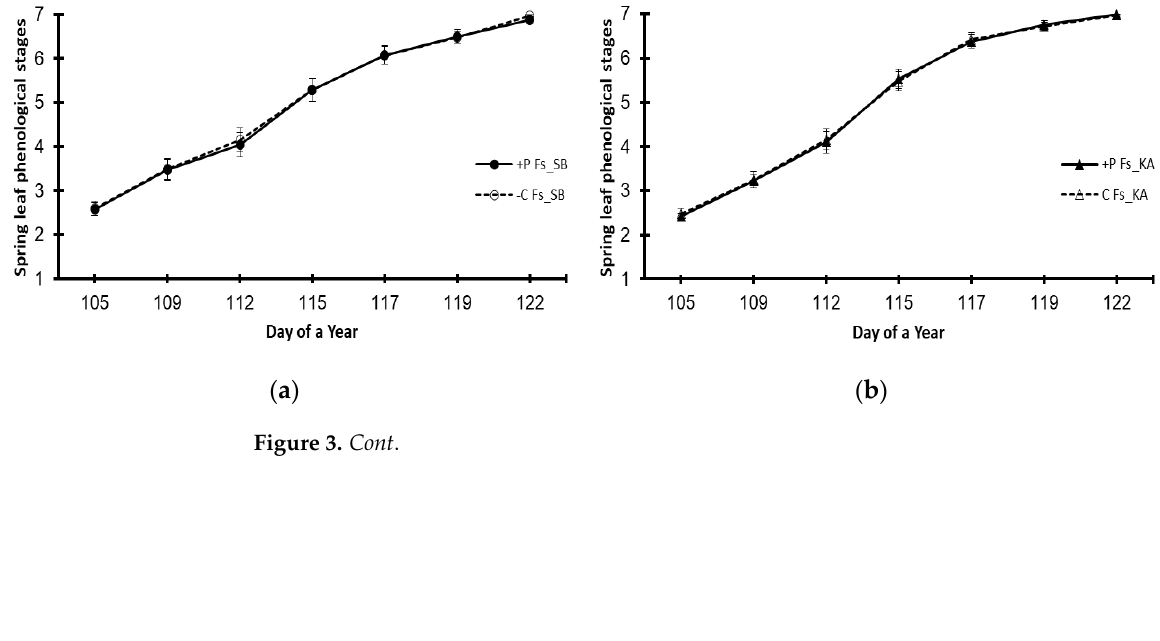
Figure 2. Autumn leaf phenologies of beech (Fs) and oak (Qp) saplings in 2021, by provenance and treatment: ( a ) beech provenance SB; ( b ) beech provenance KA; ( c ) oak provenance SB; ( d ) oak provenance KA. +P treatment—elevated phosphorus; C—control (no phosphorus added). The markers represent the means ± S.E. ( n = 50). A star denotes a statistically significant difference between the treatments on a given day of the year ( p < 0.05).